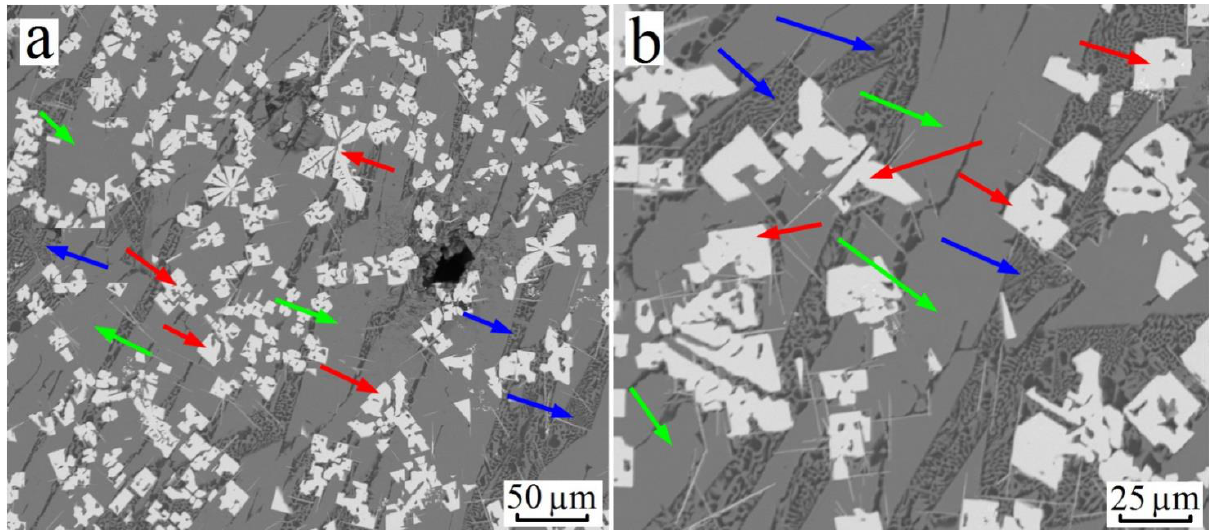
Figure 6. Distribution and growth patterns of metastable aluminides in Al – 35.66Cu – 15.36Hf (H5) alloy: ( a ) magnification × 250; ( b ) magnification × 1000. The arrows point to main structural com- ponents of the alloy: the θ -phase Al 2 Cu (green arrows), the α -Al + θ eutectic (blue arrows) and L 1 2 trialuminides (red arrows).